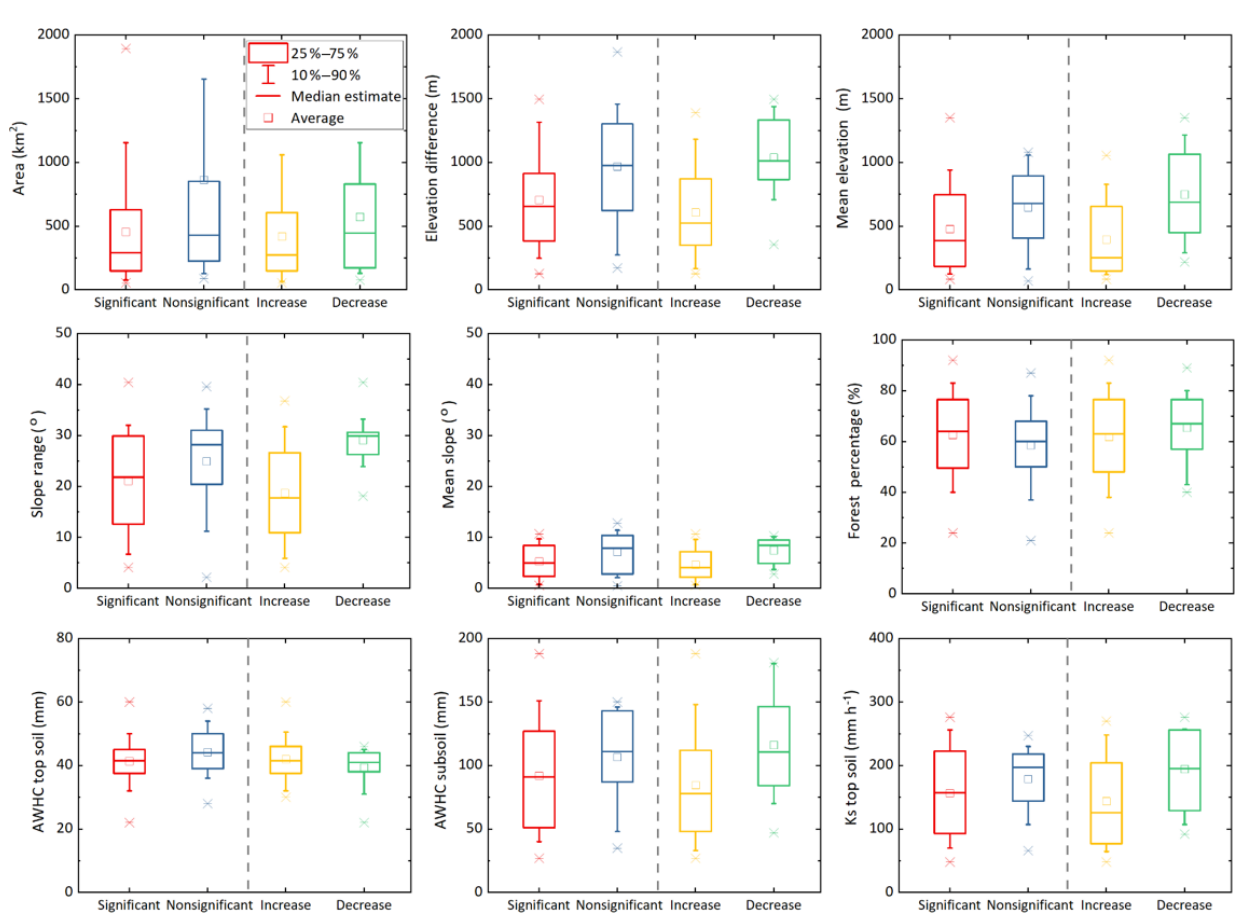
Figure 6. Catchment properties for the study catchments, including catchment area (km 2 ), elevation difference between the maximum and minimum elevations (m), mean elevation (m), slope range ( ◦ ), mean slope ( ◦ ), forest coverage percentage (%), available soil water holding capacity (AWHC) in top- and subsoils, and saturated hydraulic conductivity ( K s ) in topsoil (mmh − 1 ). The red and black lines (solid) denote the average of catchments with and without significant changes in the CWSC, respectively. “Increased” means catchments with a significant increase in the CWSC, while “decreased” represents catchments with a significant decrease in the